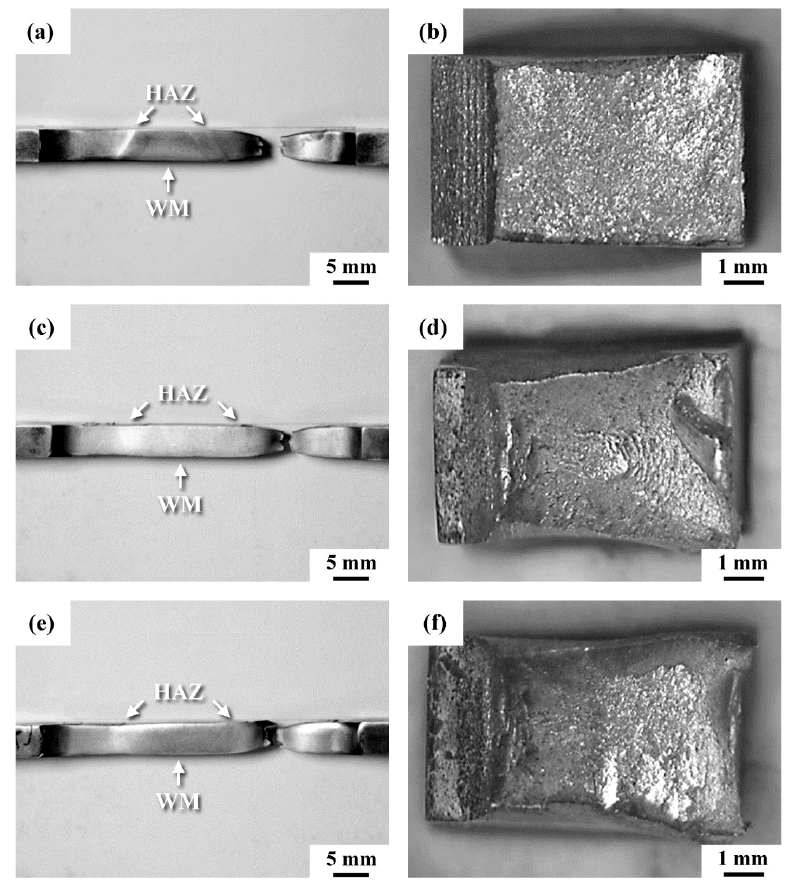
Figure 7. Appearance of the fracture zone in the welds in the ( a , b ) AW, ( c , d ) PT 1 and ( e , f ) PT 2 conditions. ( a , c , e ) the side view of the tensile fractured samples; ( b , d , f ) impact fractured samples.